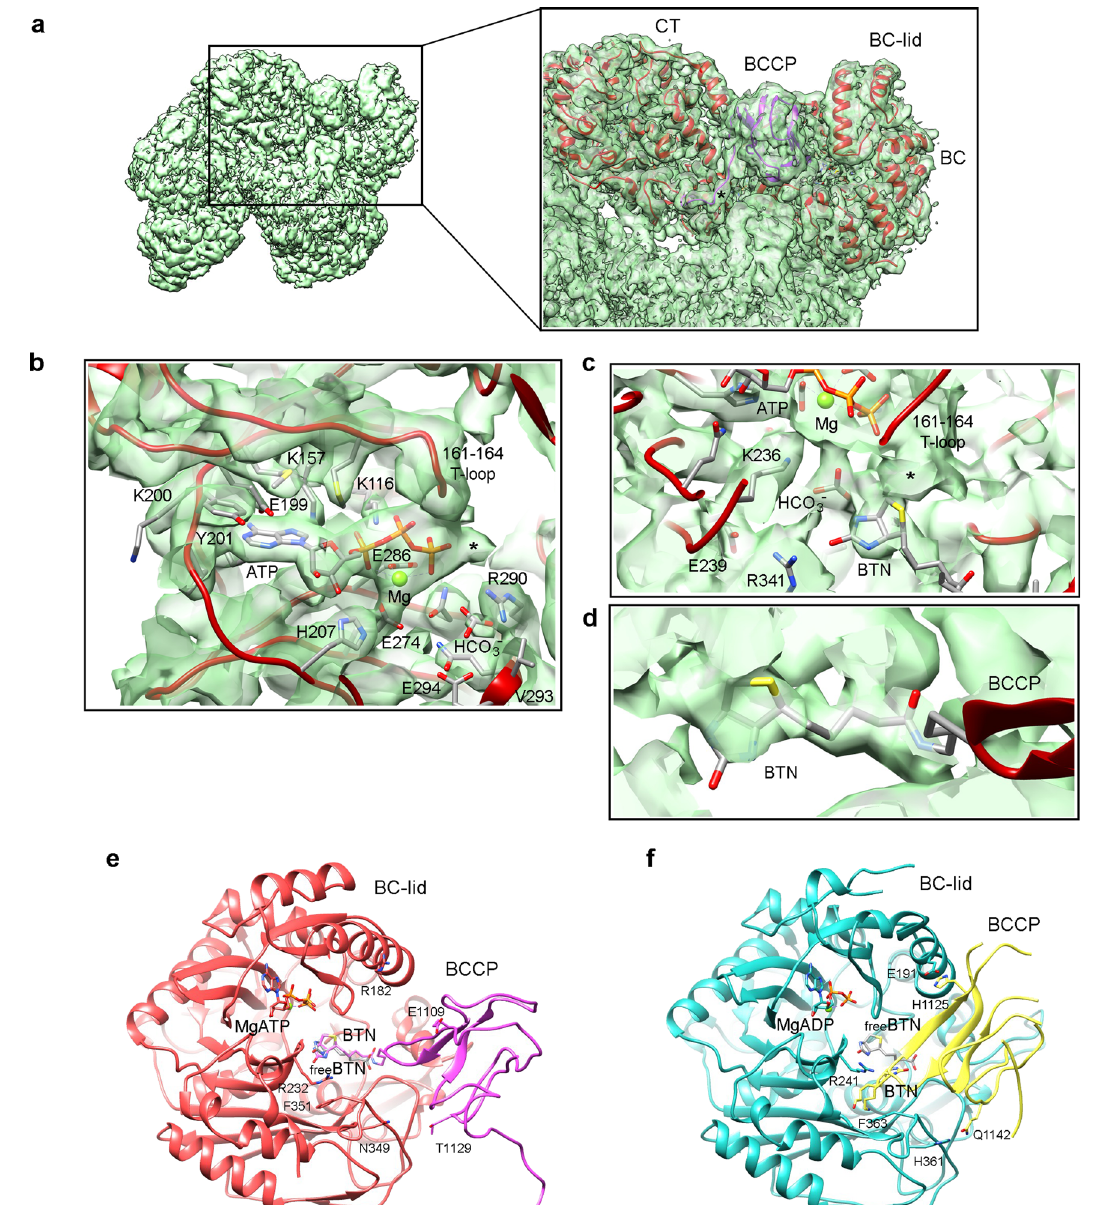
Fig. 2 | Structural details of the BCCP-BC interaction. a CryoEM map for the BC react class after classi fi cation. The atomic model for one LlPC subunit is seen in red ribbons but the BCCP domain that belongs to the same subunit is colored purpleforclarity. Asterisk inzoom panel labels the connection between BCCP and PT domains. b Interactions of the BC domain with MgATP. Asterisk locates a putativesecondMg 2+ ion. c BiotinbindingsiteinthemapforBC react .BTNstandsfor biotin. d Close-up of biotin density shown in the cryoEM map at 3.5 σ threshold.